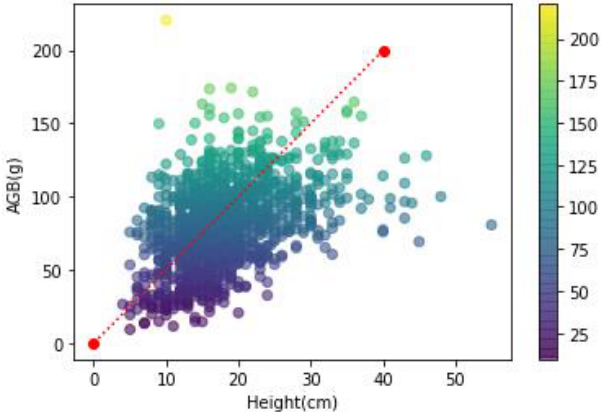
Figure 7. Scatter plot of AGB and grass height.